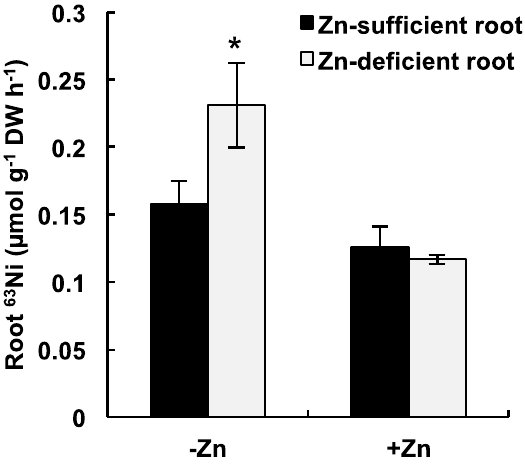
Figure 2. Short-term 63 Ni uptake by plants. Plants grown under Zn-sufficient (5 μmol·L −1 ) or -deficient (0 μmol·L −1 ) conditions for 4 days were incubated in hydroponic solutions containing 5 μmol·L −1 63 NiCl 2 in the presence of Zn (5 μmol·L −1 ZnCl 2 ) or absence of Zn (0 μmol·L −1 ) for 1 h. Asterisks denote significant differences ( p < 0.05, Wilcoxon-Mann-Whitney test) between the Zn-sufficient and -deficient roots, and the values represent means ± SD based on four independent